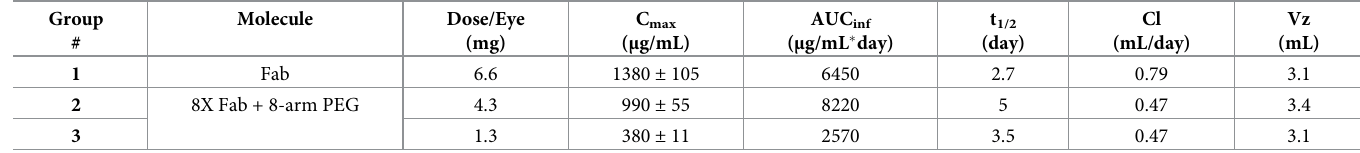
Table 5. PK parameters for Fab and 8X Fab + 8-arm PEG in NHP vitreous. Pharmacokinetic parameters are reported on the basis of AI (Fab) content. Group